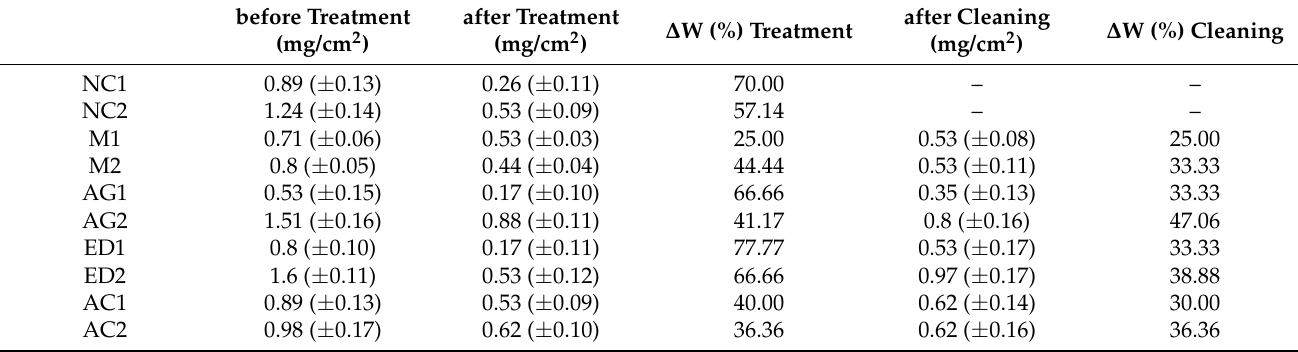
Table 2. Results of the Scotch Tape Test (STT) after treatment and cleaning